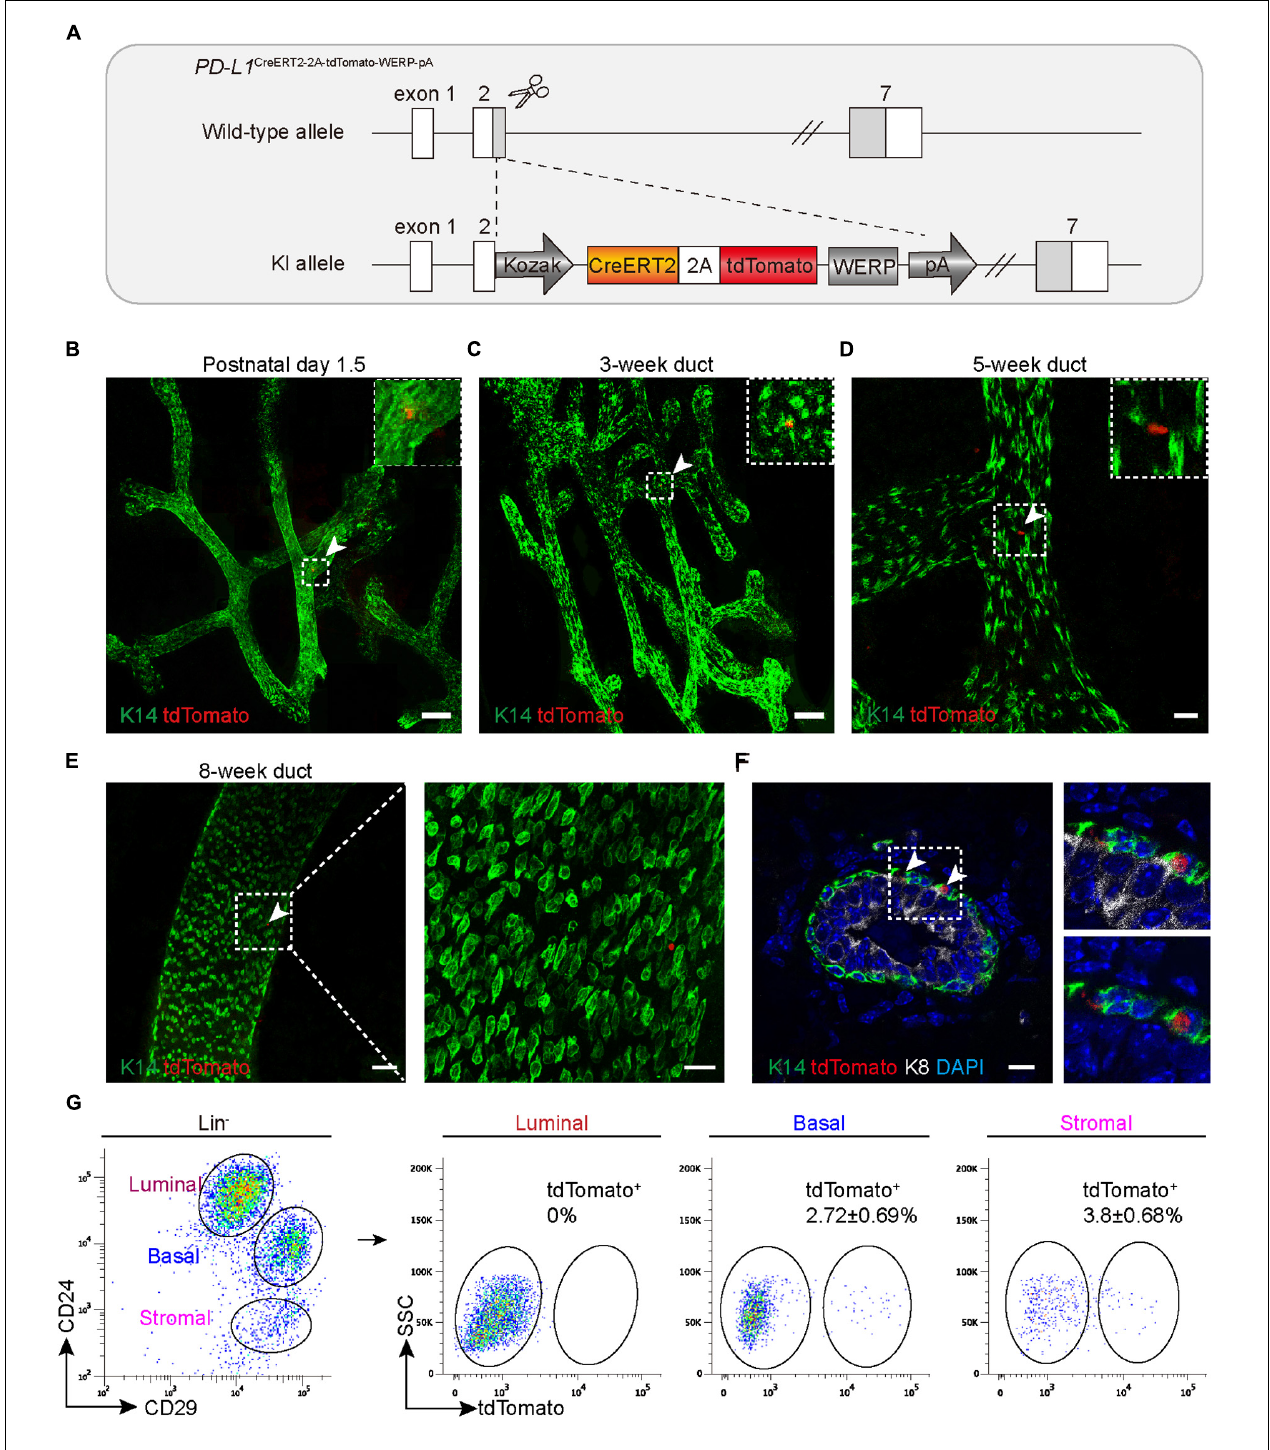
FIGURE 2 | PD-L1 CreERT2 − 2A − tdTomato knock-in mouse recapitulates the PD-L1 expression pattern. (A) Targeting strategy to generate PD-L1 CreERT2 − 2A − tdTomato knock-in (KI) mouse. (B–E) The fourth inguinal mammary glands, harvested from postnatal day 1.5 (B) , 3-week-old (C) , 5-week-old (D) , and 8-week-old, (E) PD-L1 CreERT2 − 2A − tdTomato / + KI mice, were analyzed by whole-mount confocal imaging. Individual tdTomato + cells were dispersed throughout mammary ducts at all examined stages. A minimum of 50 ducts were analyzed. Scale bars, 100 µ m in panels (B,C) , 20 µ m in panel (D) , 50 and 20 µ m in panel (E) . (F) Immunostaining analysis of mammary sections from KI mice. Scale bars, 10 µ m. (G) FACS analysis indicating that the tdTomato + cells account for 2.72 ± 0.69% of the basal cells and for 3.8 ± 0.68% of stromal cells; n = 6 mice. FACS, fluorescence-activated cell sorting; PD-L1, programmed cell death ligand